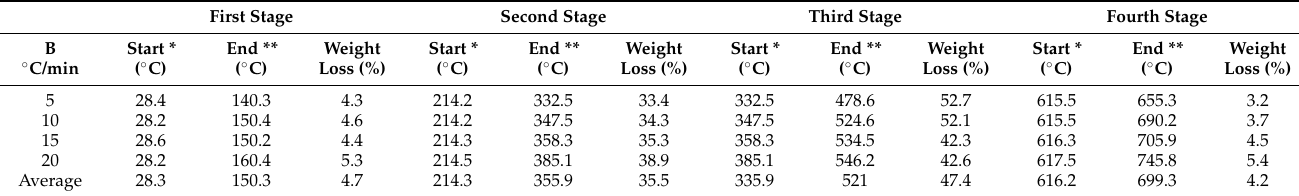
Figure 2. The effect of the heating rate in CO 2 : ( a ) conversion degree and ( b ) DTG weight loss. Table 4. Thermal decomposition of Subcoal™ PAF in air from TGA Table 2. Thermal decomposition of Subcoal™ PAF in N 2 from TGA curves.